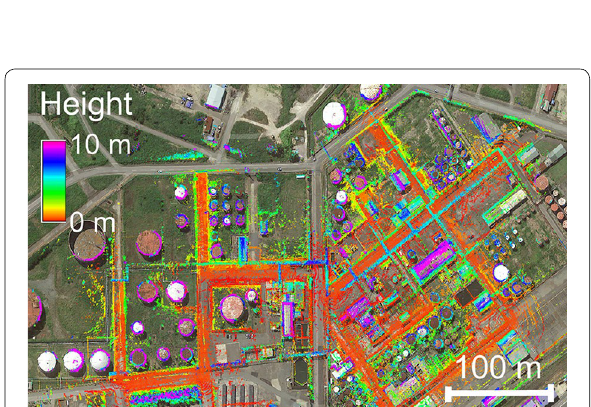
Fig. 12 3D map built from FS 2.0 based on GPS and LIDAR (consist- ency with the aerial map): 3D point cloud with correct building shapes and 3D point cloud positions aligned with the aerial